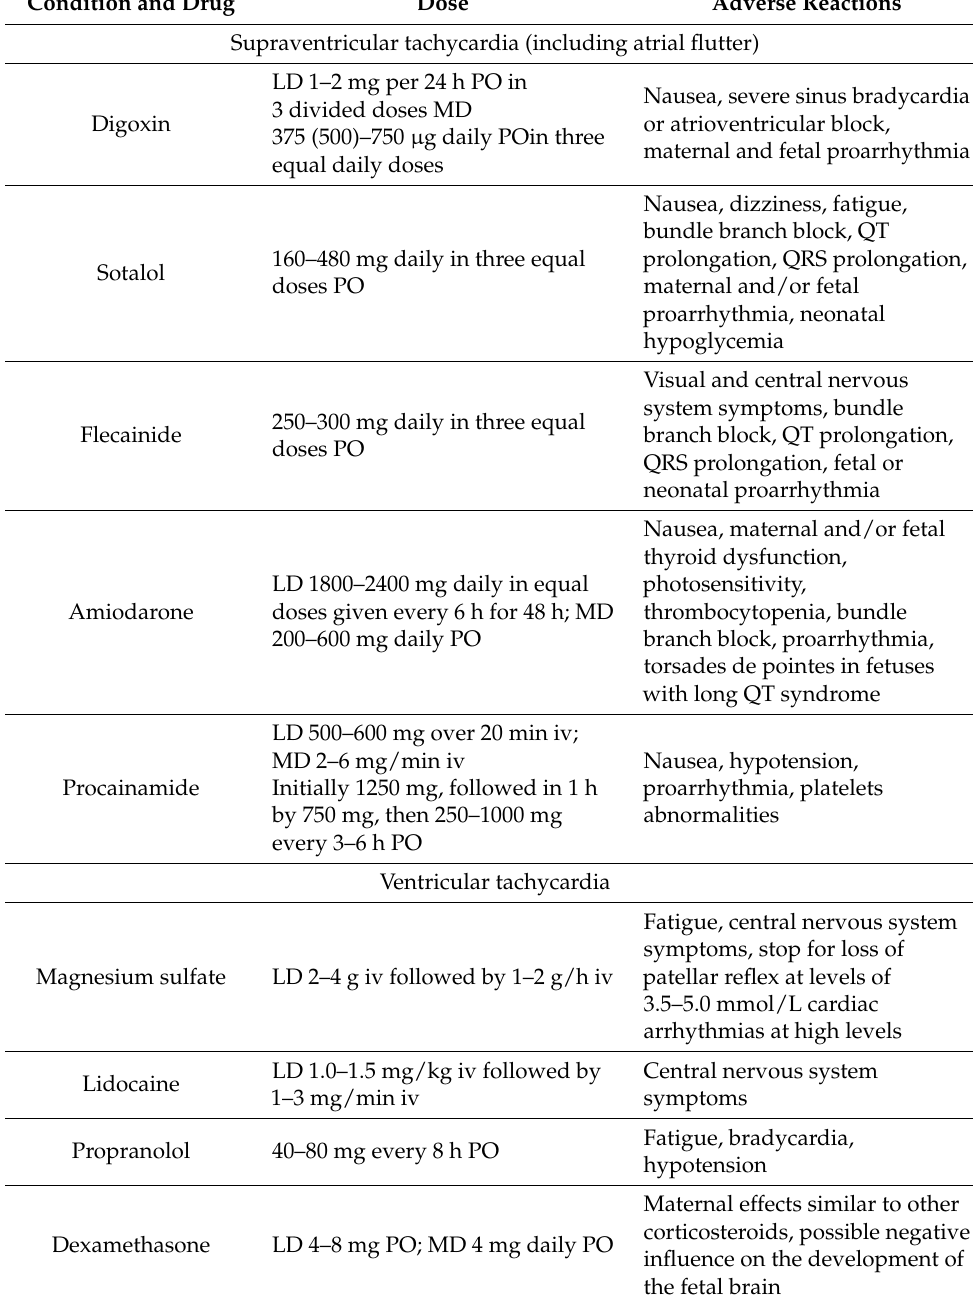
Table 1. Agents used to treat fetal tachyarrhythmia